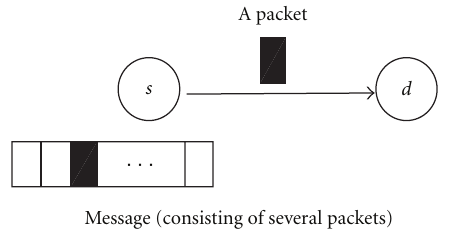
Figure 1: Link model: node s sends a packet of message to node d over link ( s , d ).